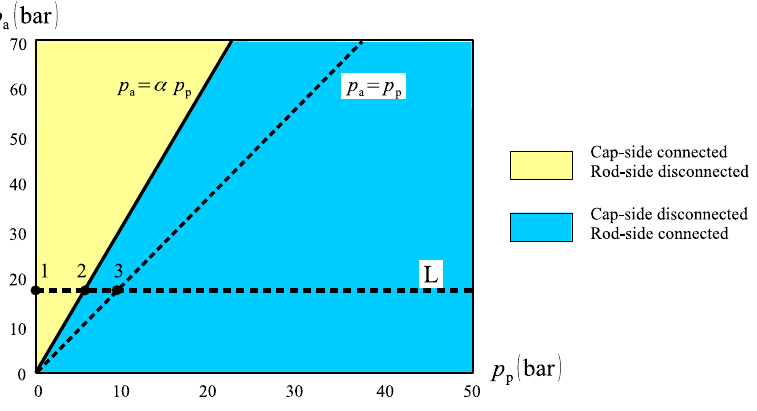
Figure 29. Compensation flow connections for the circuit in Figure 8.